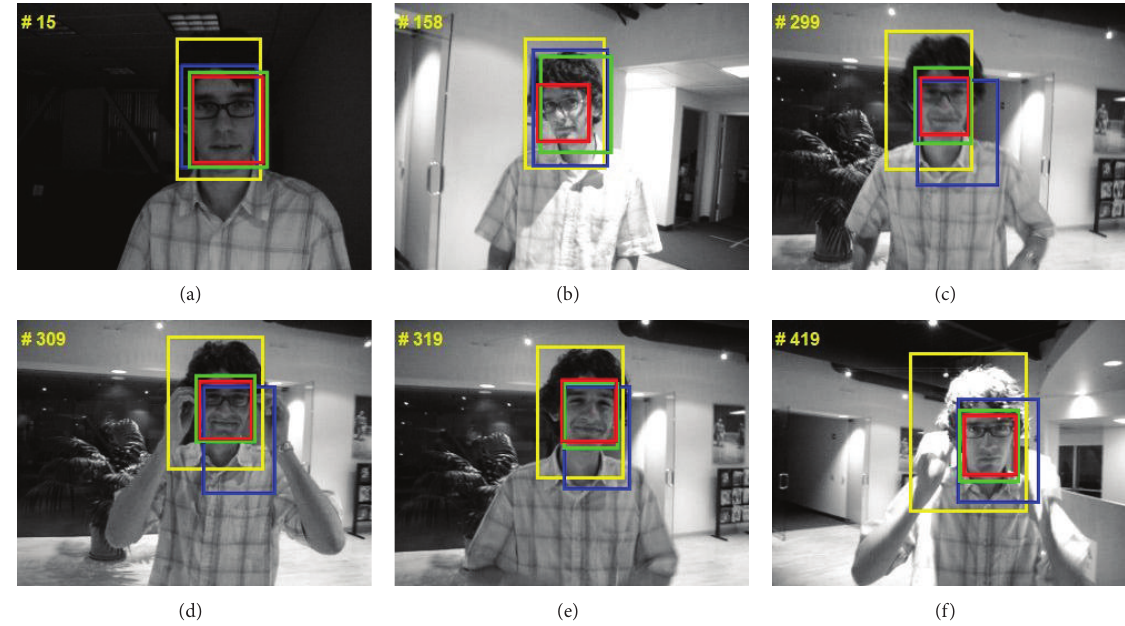
Figure 7: Tracking results of the David Indoor sequence (MIL is yellow, IVT is blue, L1 is green, and our tracker is red).